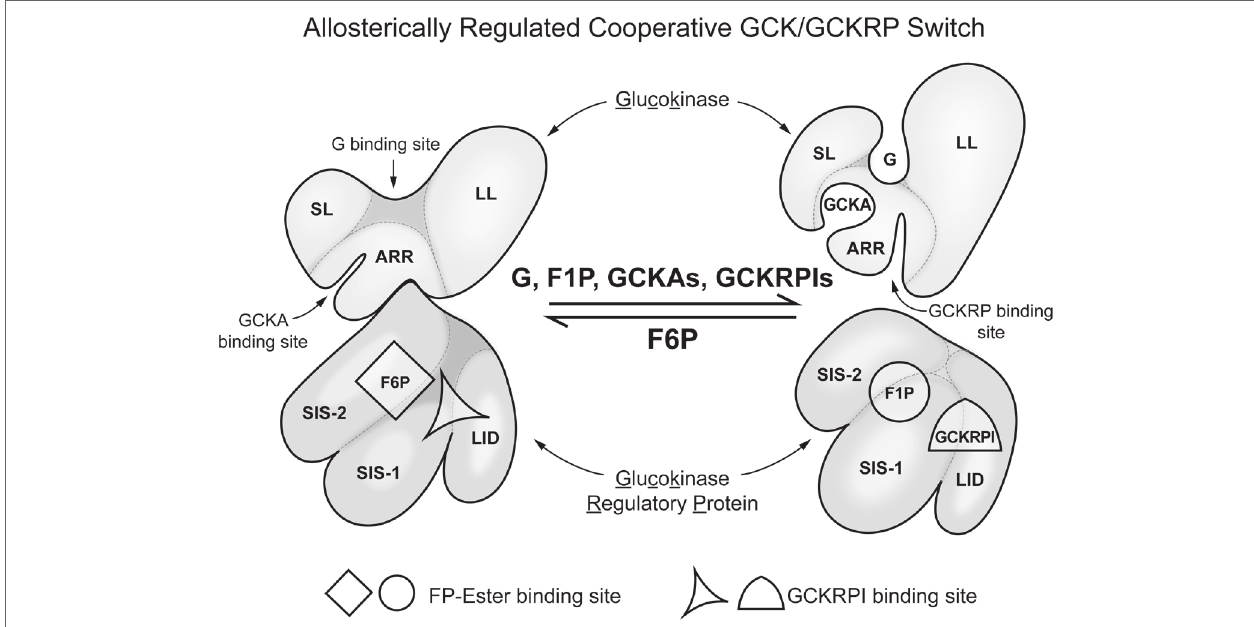
FIGURE 3 | Regulation of glucokinse activity in liver by liver specific GCK regulatory protein (GCKRP). In hepatocytes, in contrast to glucose sensing cells in regulation of glucose homeostasis, there is a specific inhibitory protein that regulates GCK activity. The figure schematically represents the association of GCK and GCKRP and the metabolic factors that affect that interaction. This can be considered a “switch” that turns enzyme activity on when blood glucose in elevated and off when it is low relative to normal (for background and details, see Zelent et al. (2014). SL, small lobe; LL, large lobe; ARR, allosteric regulatory region; SIS-1, sugar isomerase; SIS-2, sugar isomerase-2; LID,